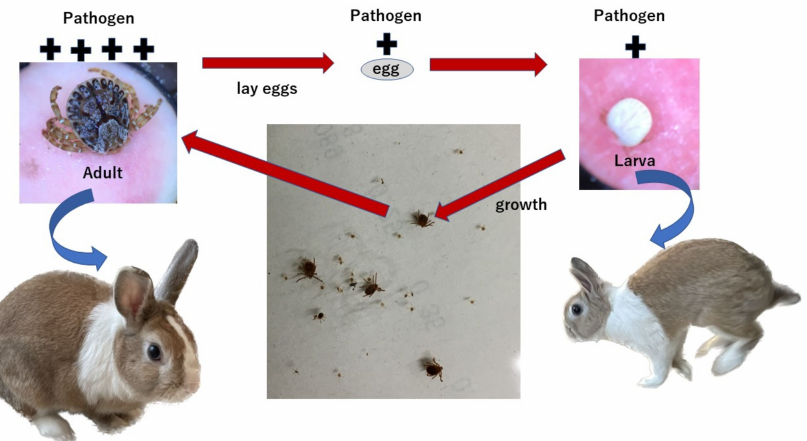
Figure 2. As ticks grow, pathogens multiply inside them. Adult ticks suck blood from wild animals and lay eggs, and tick-borne pathogens are present in the eggs. A few tick-borne pathogens are also present in larval ticks that have not yet sucked blood from a wild